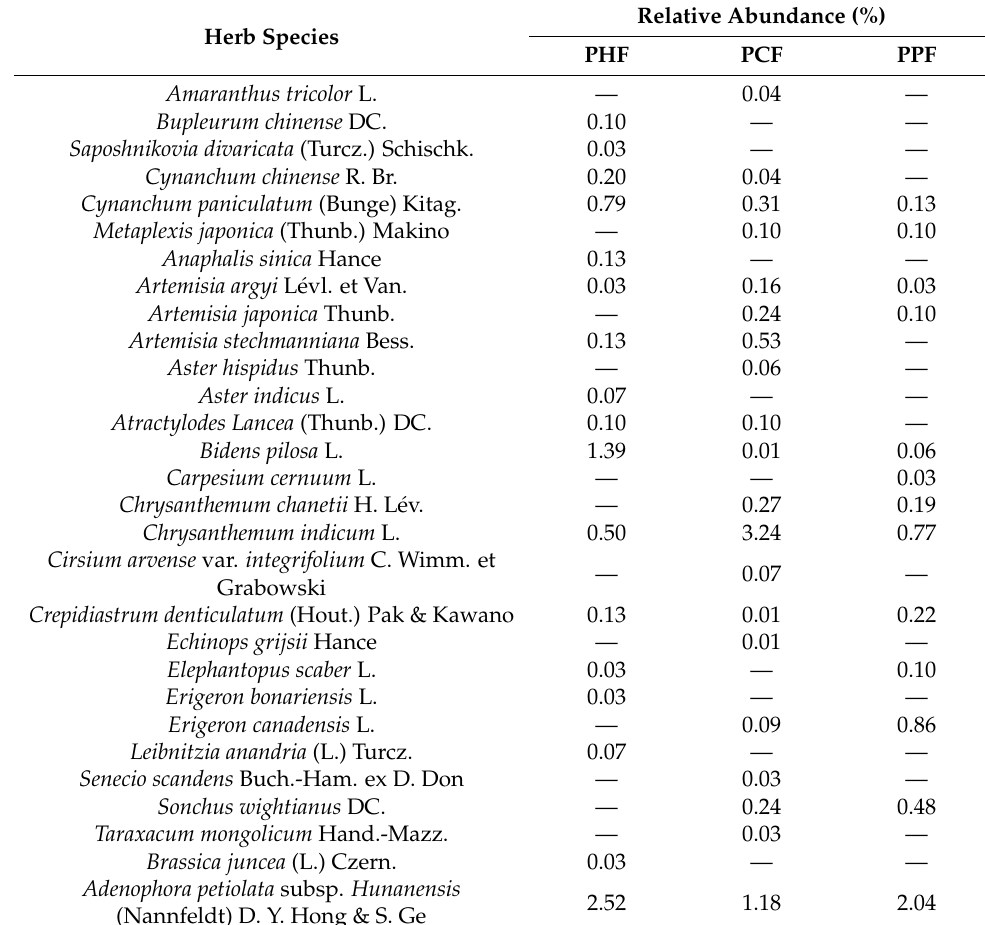
Brassica juncea (L.)